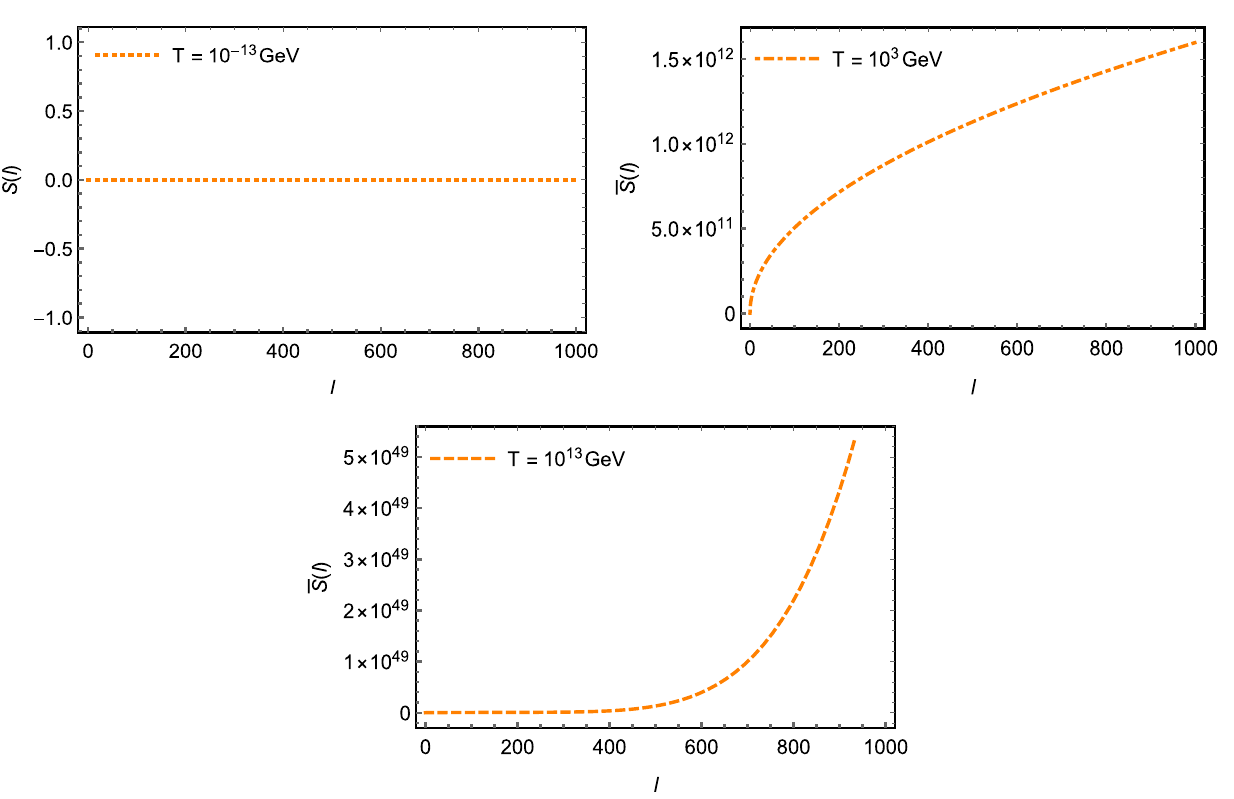
Fig. 11 The figure shows the modification of the entropy ¯ S as a function of l ( whose dimension is m · kg − 1 / 2 · s − 1 ) considering the temperatures of cosmic microwave background (top left), electroweak scenario (top right) and the early inflationary universe